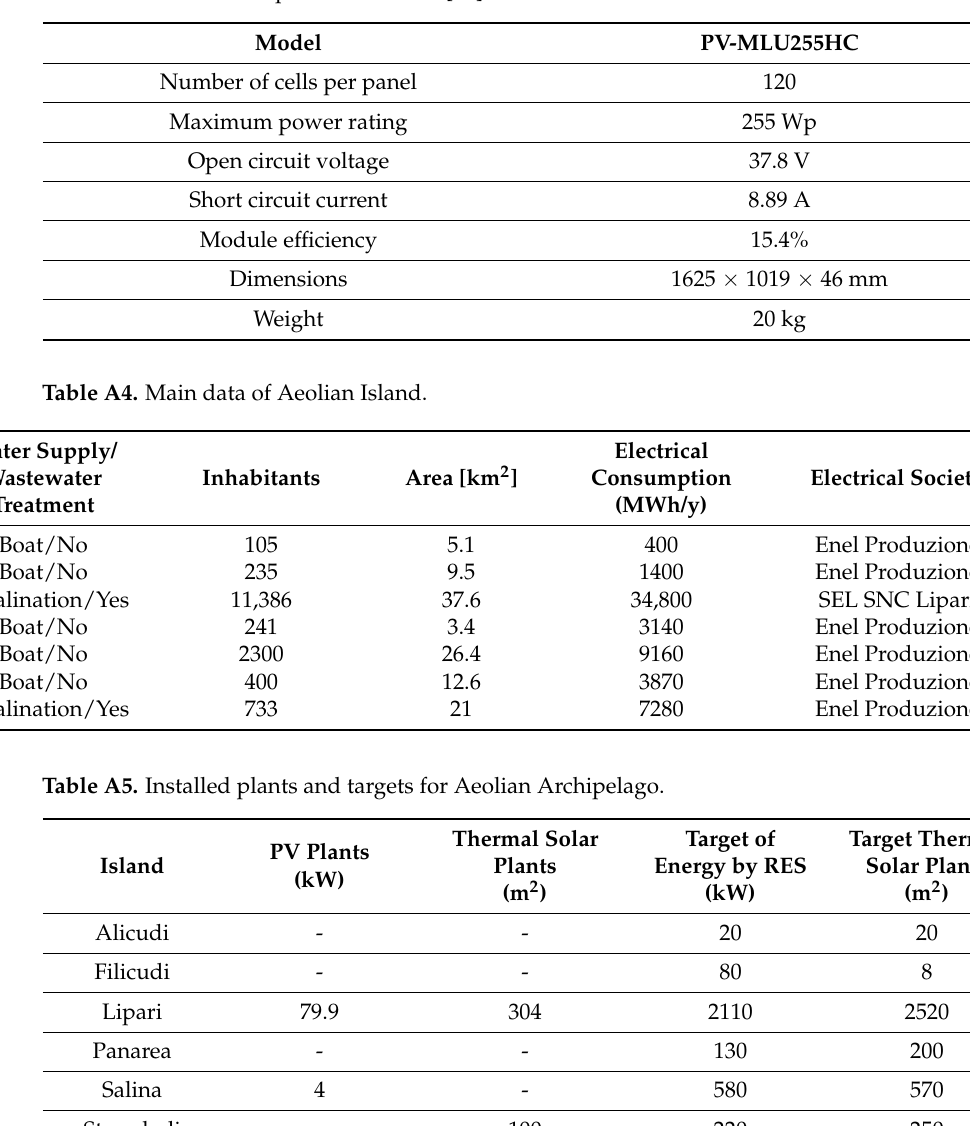
Table A3. Photovoltaic panels datasheet [41].